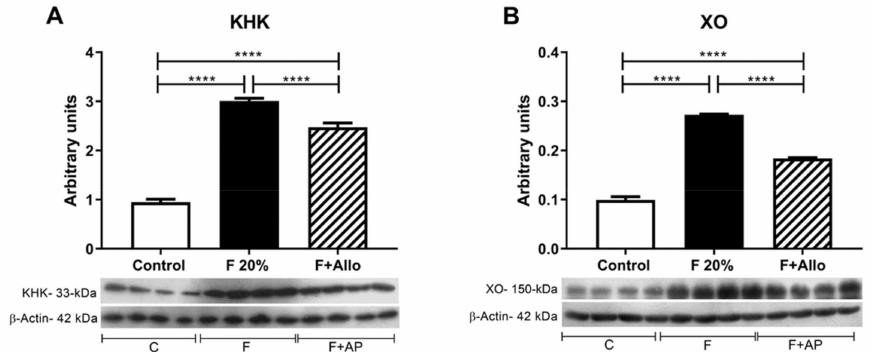
Figure 3. Fructokinase (KHK) and XO (xanthine oxidase) protein expression in liver. High fructose intake induced the upregulation of KHK ( A ) and XO ( B ) expression in liver. Allopurinol prevented this e ff ect. For western blotting, 4 out of 5 randomly selected samples per group were analyzed. **** = p <